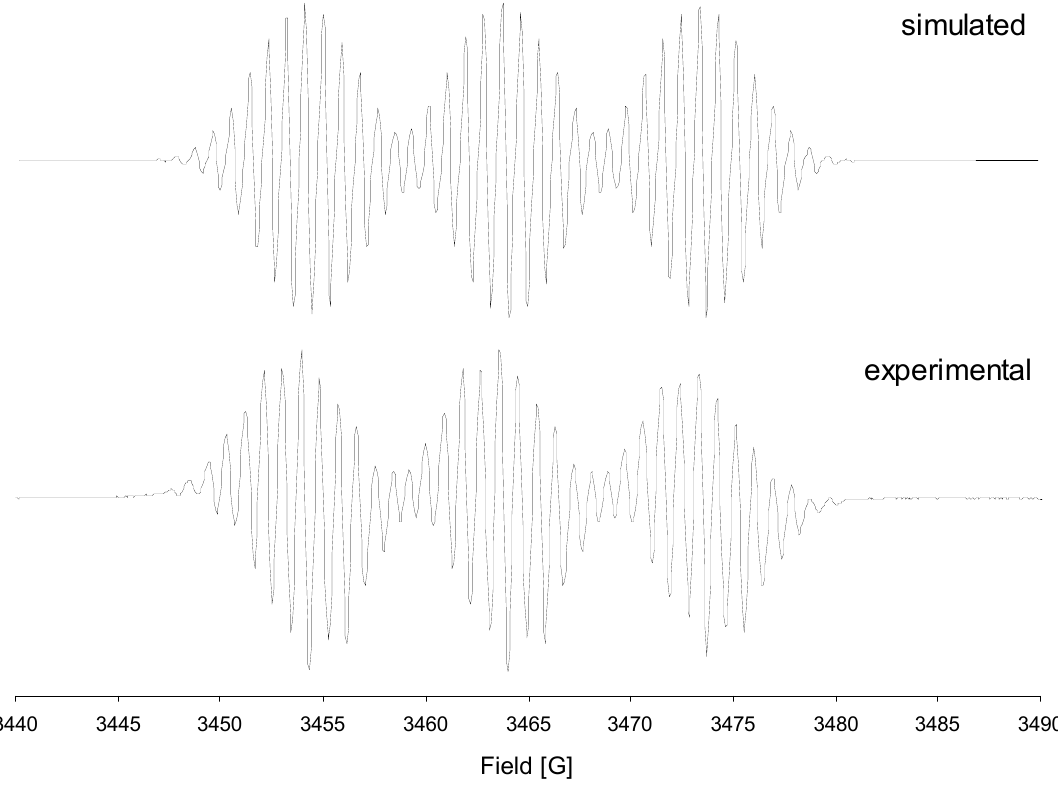
Figure 3. EPR spectrum of Ph 2 N-O • , generated in the reaction of complex 3 and Ph–N=O in the presence of FcOTf in THF. Top: simulated spectrum, bottom: experimental spectrum. Frequency: 9.746 GHz; g-value ( vs. DPPH): 2.0047; hyperfine coupling constants: a N : 27.1 MHz, a H,ortho/para : 5.1 MHz, a H,meta : 2.5 MHz.